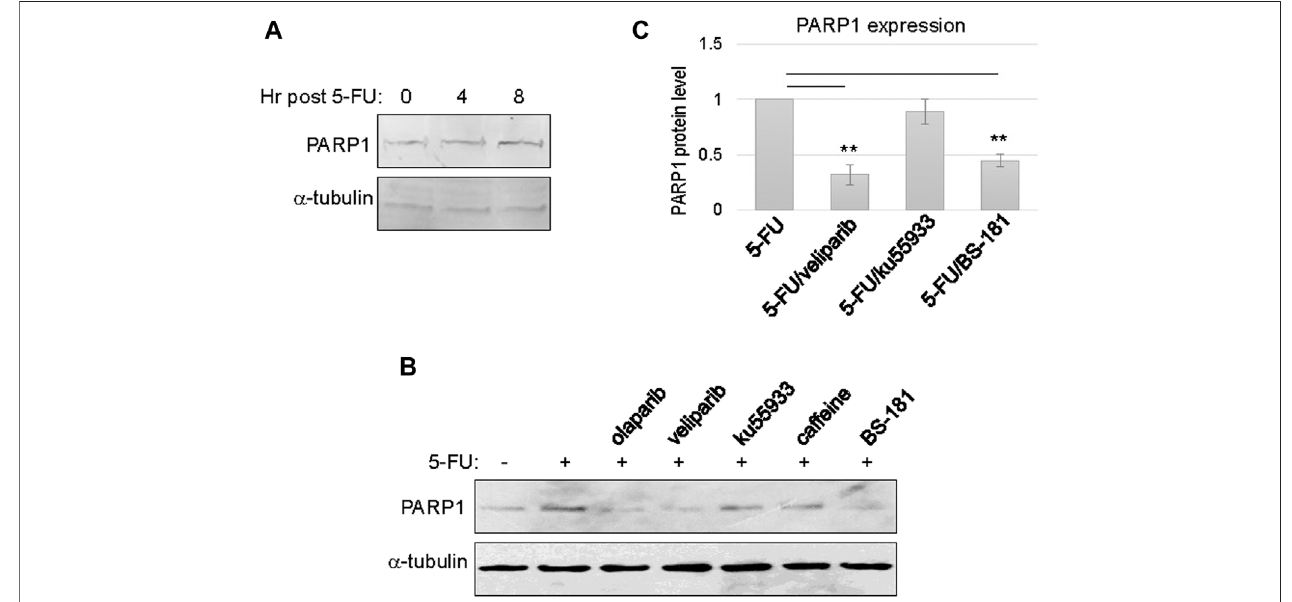
FIGURE 2 | PARP1 upregulation upon chemotherapeutic treatments in recurrent oral tumor cells. (A) SCC11B cells were treated with or without 5-FU (10 μ M), as indicated, for 4 or 8 h. The treated and untreated cells were analyzed by immunoblotting for PARP1 and α -tubulin. (B) SCC11B cells were treated with or without 5-FU (10 μ M), in combination with olaparib (10 μ M), veliparib (10 μ M), Ku55933 (10 μ M), caffeine (3 mM), and BS-181 (1 μ M), as indicated, for 1 day. The treated and untreatedcells wereanalyzedby immunoblotting forPARP1 and α -tubulin. (C) Quanti fi cation ofPARP1 expression inpanel (B) . The relative PARP1 protein level in cellswithcombinationdrugtreatmentswasnormalizedtothatincellstreatedwith5-FUalone.Theaverageofthreeindependentexperimentswasshown,withstatistical analysis.